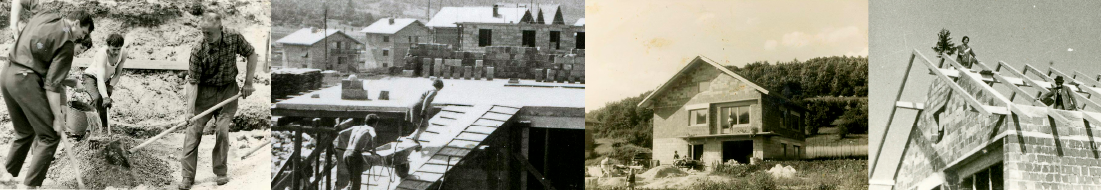
Figure 3. Archival images of the DIY building process. Source: http://stareslike.cerknica.org, accessed on 1 February 2023, provided by Franc Perko; left and centre-left [18] and Alojz Janeš; centre-right and right [19].